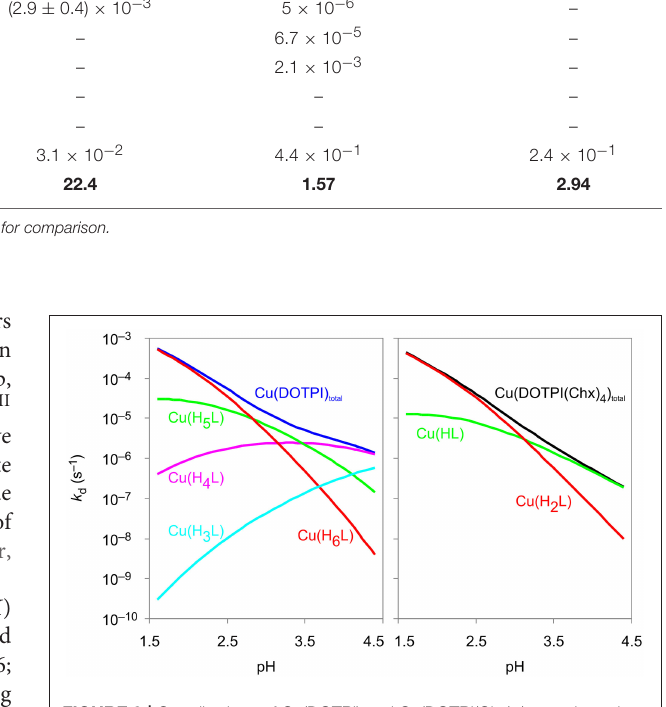
rates (see also Figures S3, S6), which decrease with increasing pH. In the pH range 1.5–4.5, dissociation of Cu(DOTPI)